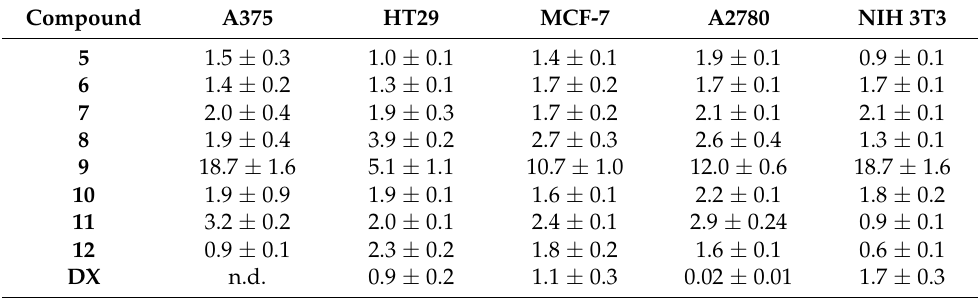
Table 2. Cytotoxicity of 3- O -acetylated triterpenoic amides 5 – 8 (piperazinyl amimides) and 9 – 12 (homopiperazinyl amides) (EC 50 -values in µ M from SRB-assays) after 72 h of treatment; the values are averaged from three independent experiments performed each in triplicate, confidence interval CI = 95%; mean ± standard mean error); n.d. not determined; n.s. not soluble; doxorubicin ( DX ) was used as a positive control. Cell lines: malignant: A375 (melanoma), HT29 (colon adenocarcinoma), MCF-7 (breast adenocarcinoma), A2780 (ovarian carcinoma); non-malignant: NIH 3T3 (fibroblasts). Compound